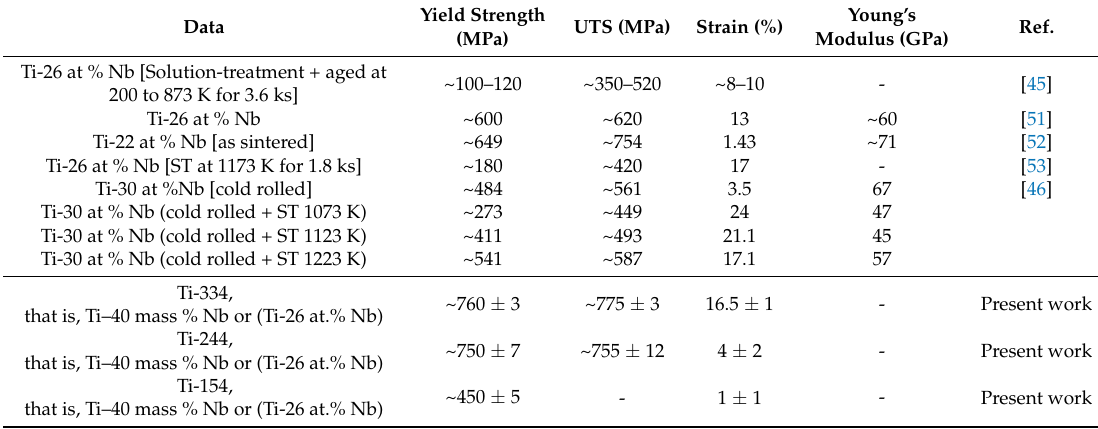
Table 5. Mechanical properties of Ti–Nb alloys processed by various